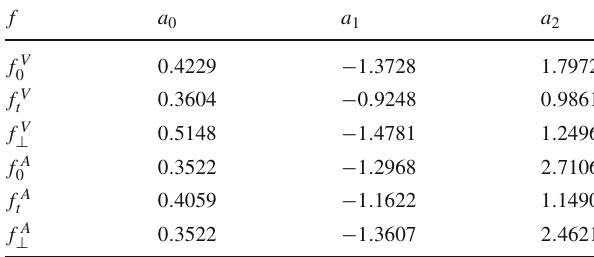
Table 5 Central values of the higher order form factor